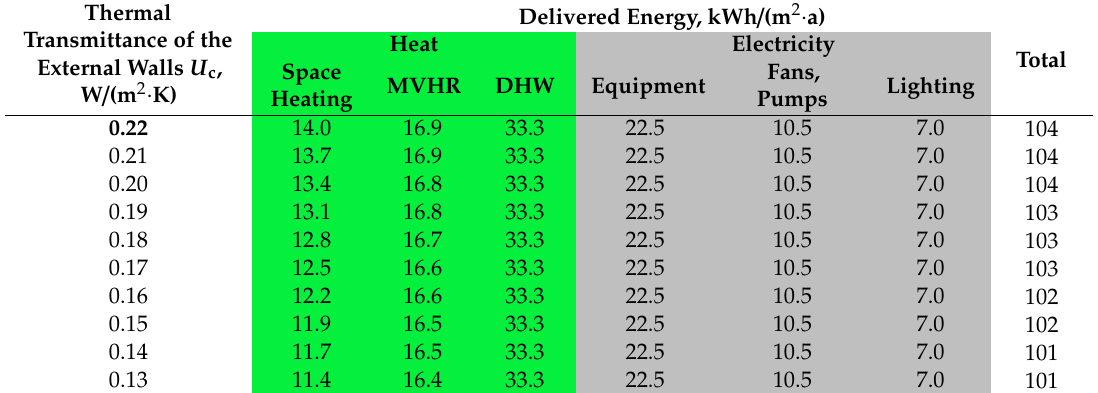
Table 7. Influence of thermal transmittance of external walls on the use of delivered energy by the apartment